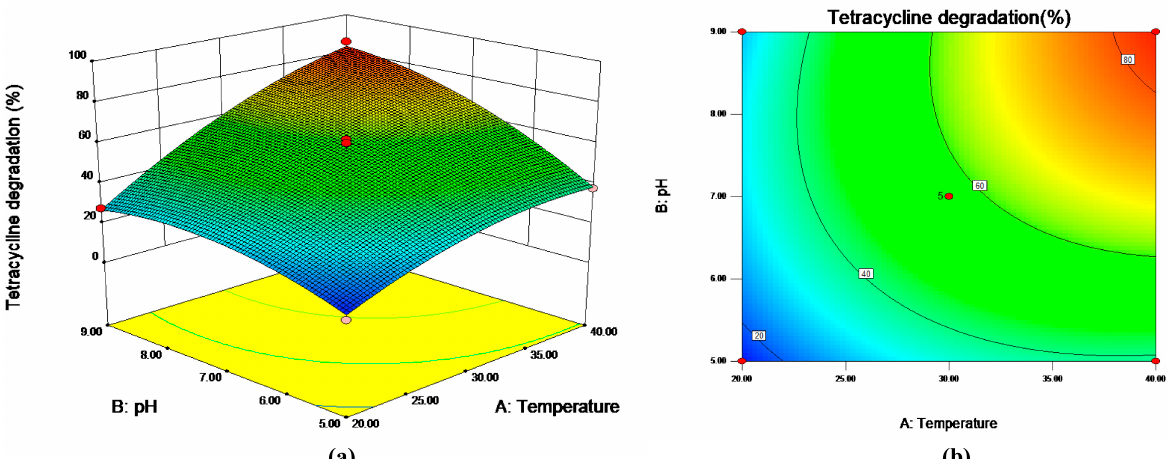
Figure 3. Response 3D surface ( a ) and contour plot ( b ) for the change in tetracycline degradation under different temperatures and pH values with fixed inoculum volume of 5.5% ( v / v